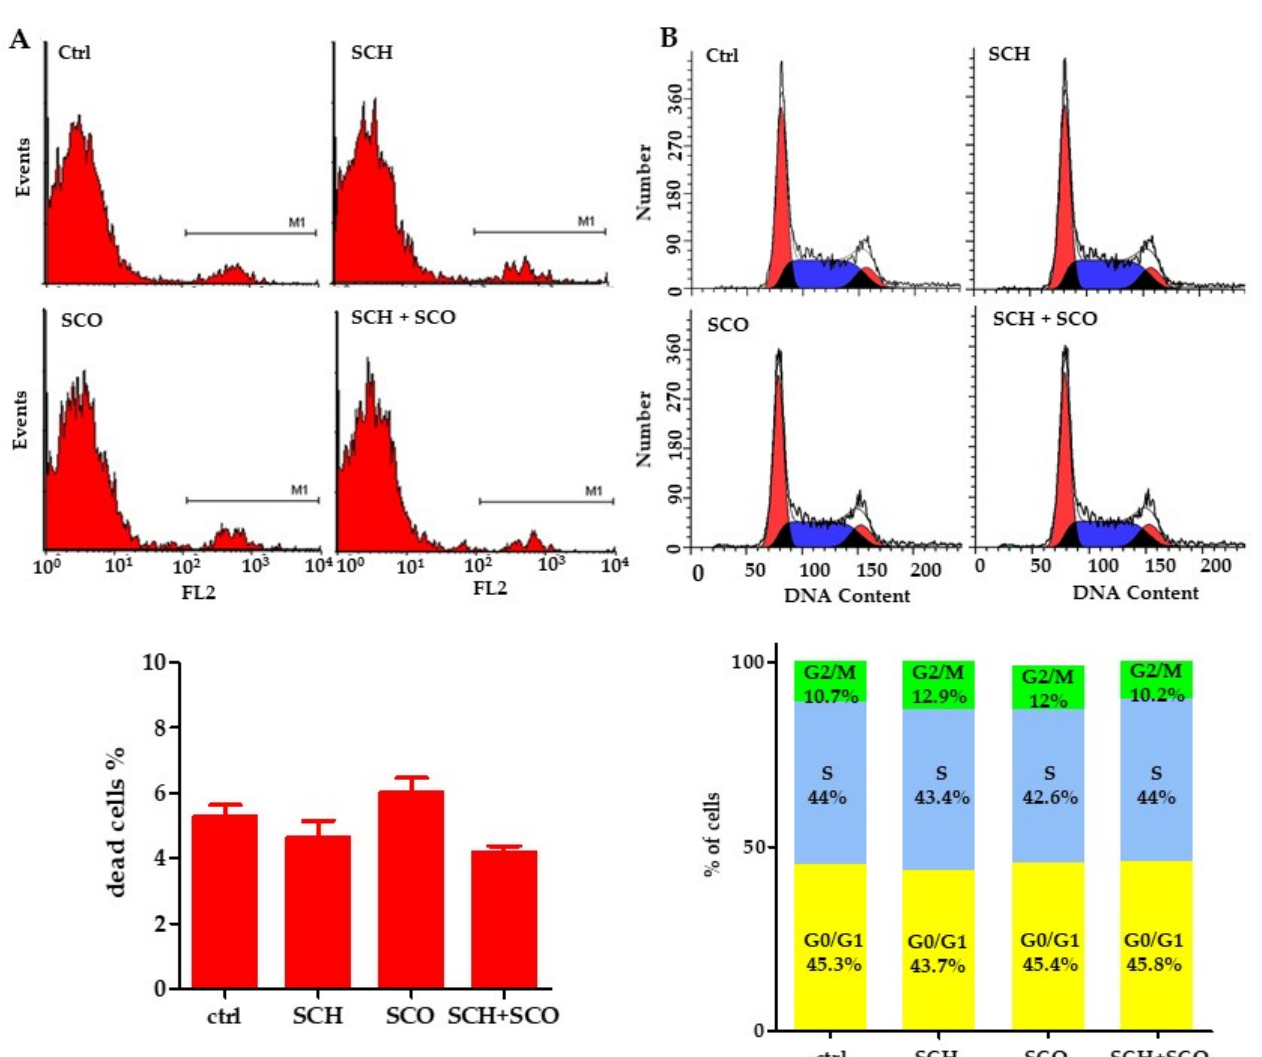
Figure 4. Effects of chloroformic extracts on cell viability and cell cycle phases in IGROV1. ( A ) Cell viability was tested by flow cytometry 24 h after treatment. Above: representative cytofluorimetric plots. Below: percentage of dead cells. Data are reported as mean ± SD of 3 independent experiments. ( B ) Cell cycle distribution. Above: cell cycle analysis by flow cytometry in control cells and in treated cells. Below: the column graph shows the percentage of cells in each cell cycle phase.